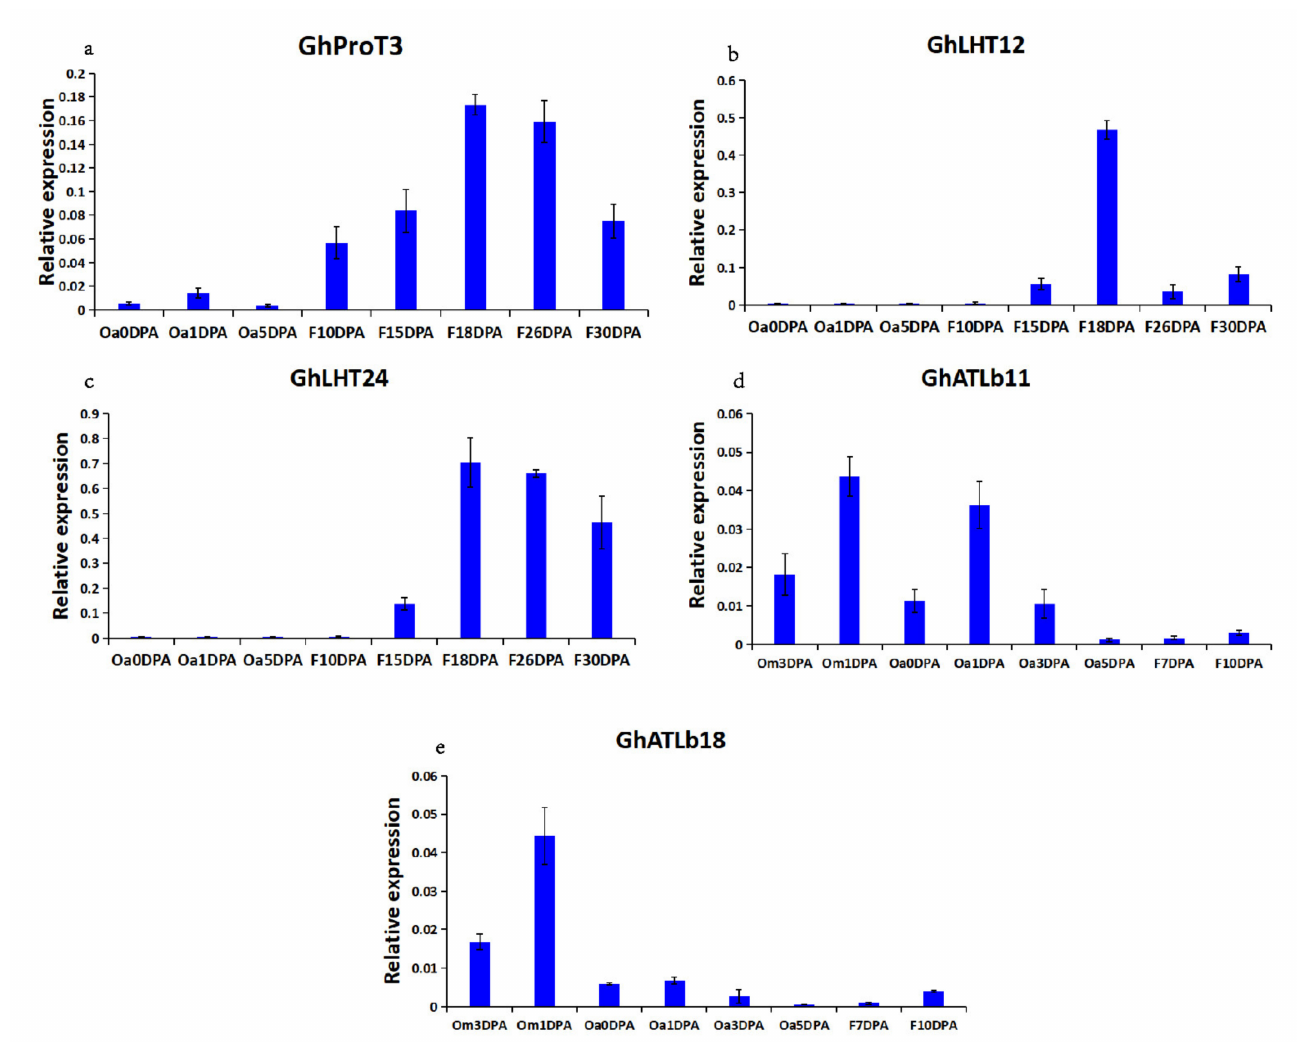
Figure 7. Expression patterns of AATs in different fiber development stages via RT qPCR. ( a – e ) Represent the expression patterns of GhProT3, GhLHT12, GhLHT24, GhATLb11, GhATLb18 genes in different fiber development stages. Note: − 3 DPA to 30 DPA indicated by − 3, − 1, 0, 1, 3, 5, 7, 10, 15, 18, 26, 30 DPA. The error bars showed the standard deviation of three biological